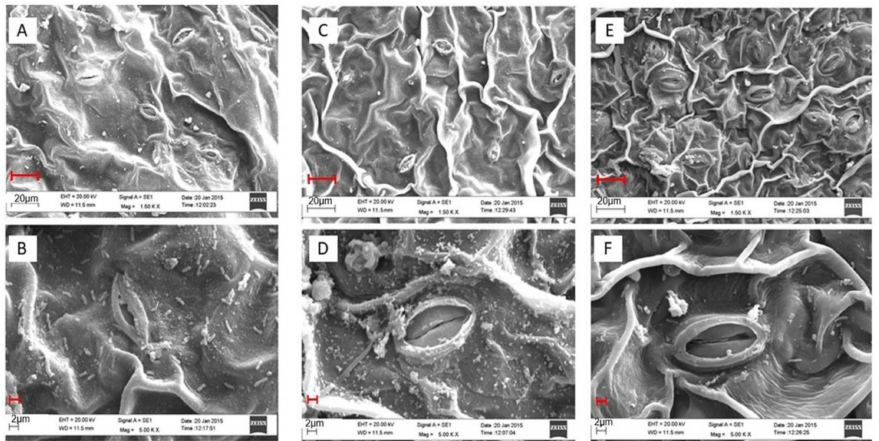
Figure 2. Stomatal behavior of mustard leaves ( A , B ) under control, ( C , D ) 100 mM NaCl, and ( E , F ) 200 mg S kg − 1 soil + 200 µ L L − 1 ethephon with 100 mM NaCl at 30 days after sowing. The opening and closing of stomata were observed under scanning electron microscope at a magnification of 1.5 kx ( A , C , E ) and 5.0 kx ( B , D , F ) in mustard leaves treated with 100 mM NaCl at 30 d after sowing. Bars ( A , C , E ) = 20 µ m; bars ( B , D , F ) = 2 µ m.